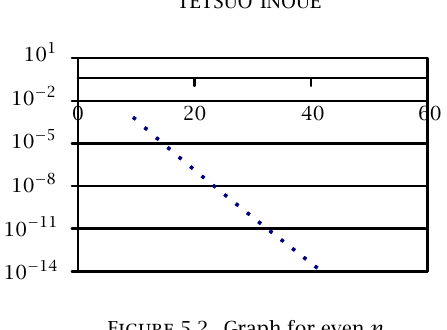
Figure 5.2 . Graph for even n .